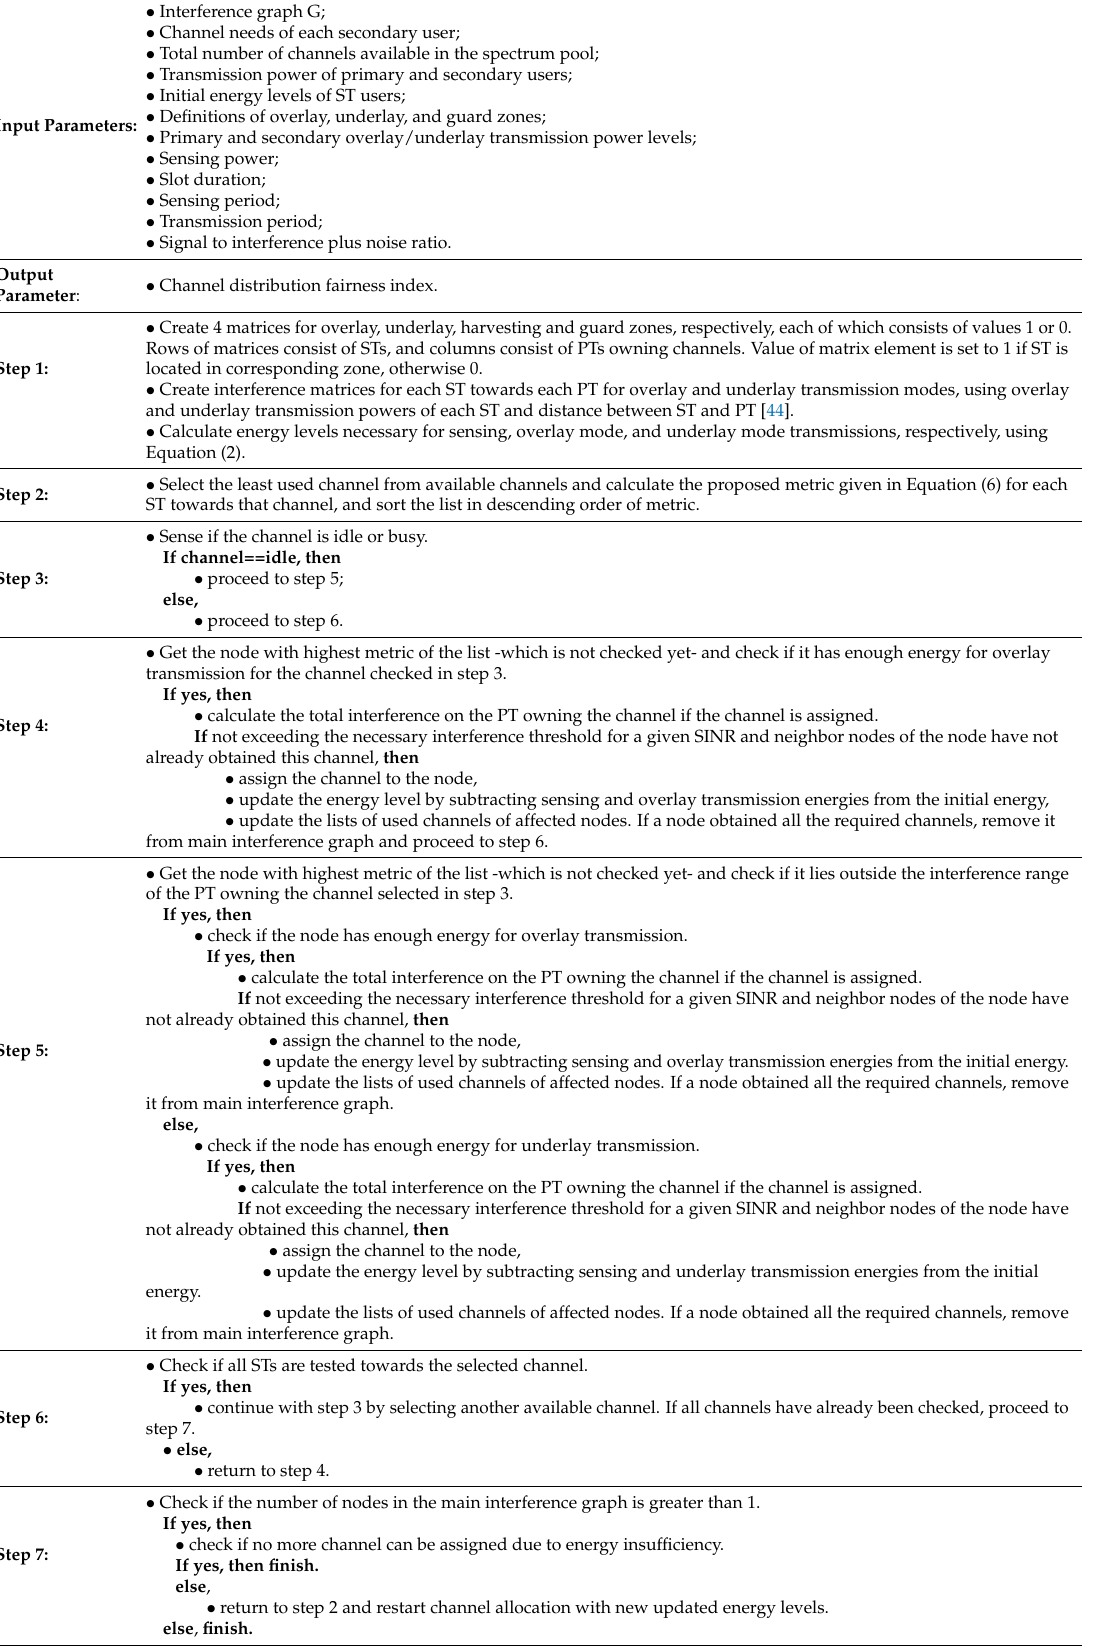
Table 3. Proposed Algorithm Using Proposed Metric of